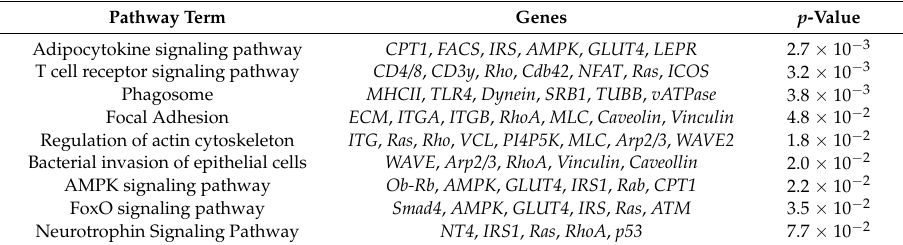
Table 1. KEGG pathway analysis of candidates predicted by RNAhybrid software.